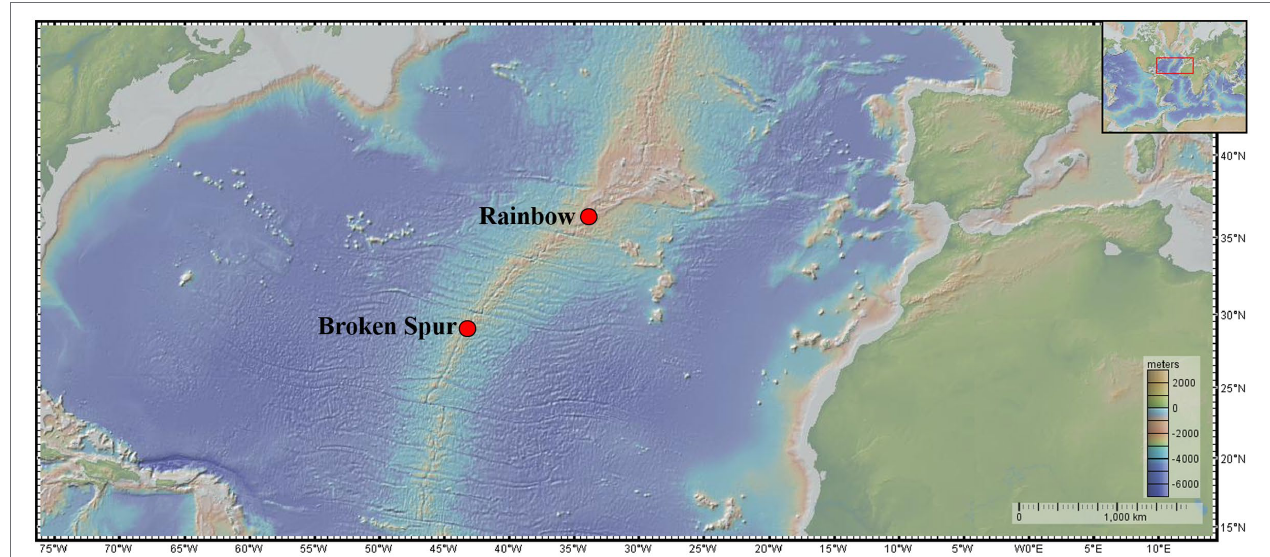
FIGURE 1 | Map showing the location of the vent fields visited along the Mid-Atlantic Ridge. Map courtesy of